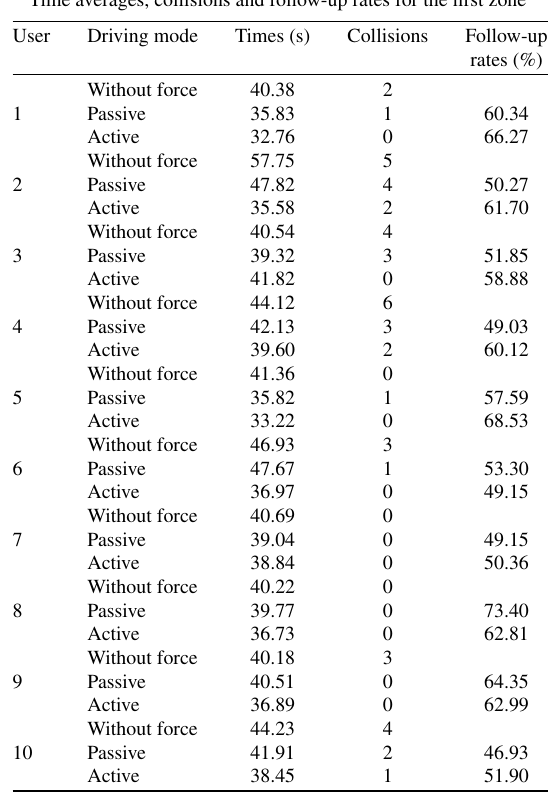
Table 1 Time averages, collisions and follow-up rates for the first